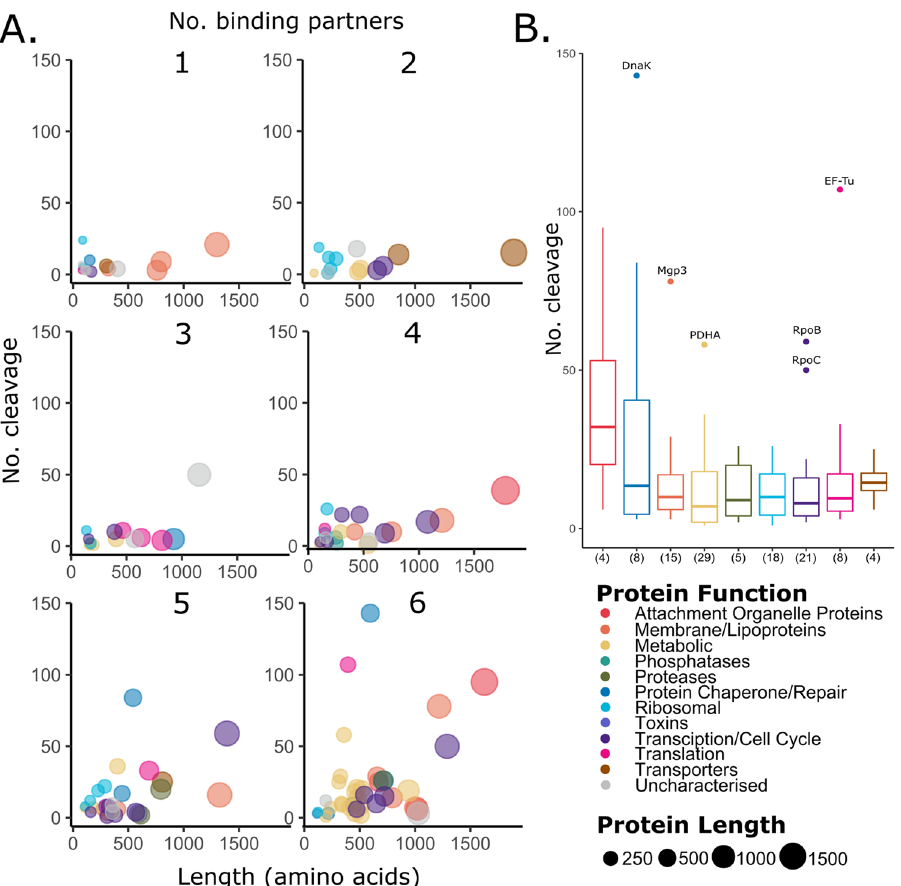
Figure 3. Endoproteolytic processing and putative binding interactions of M. pneumoniae surface proteins. ( A ) Multi-panel bubble chart displaying the relationship between protein length and number of cleavage, split by the number of binding partners (1 to 6 ECM molecules). ( B ) Boxplot showing number of cleavages observed in each functional group. The number of proteins assigned to each group is shown in